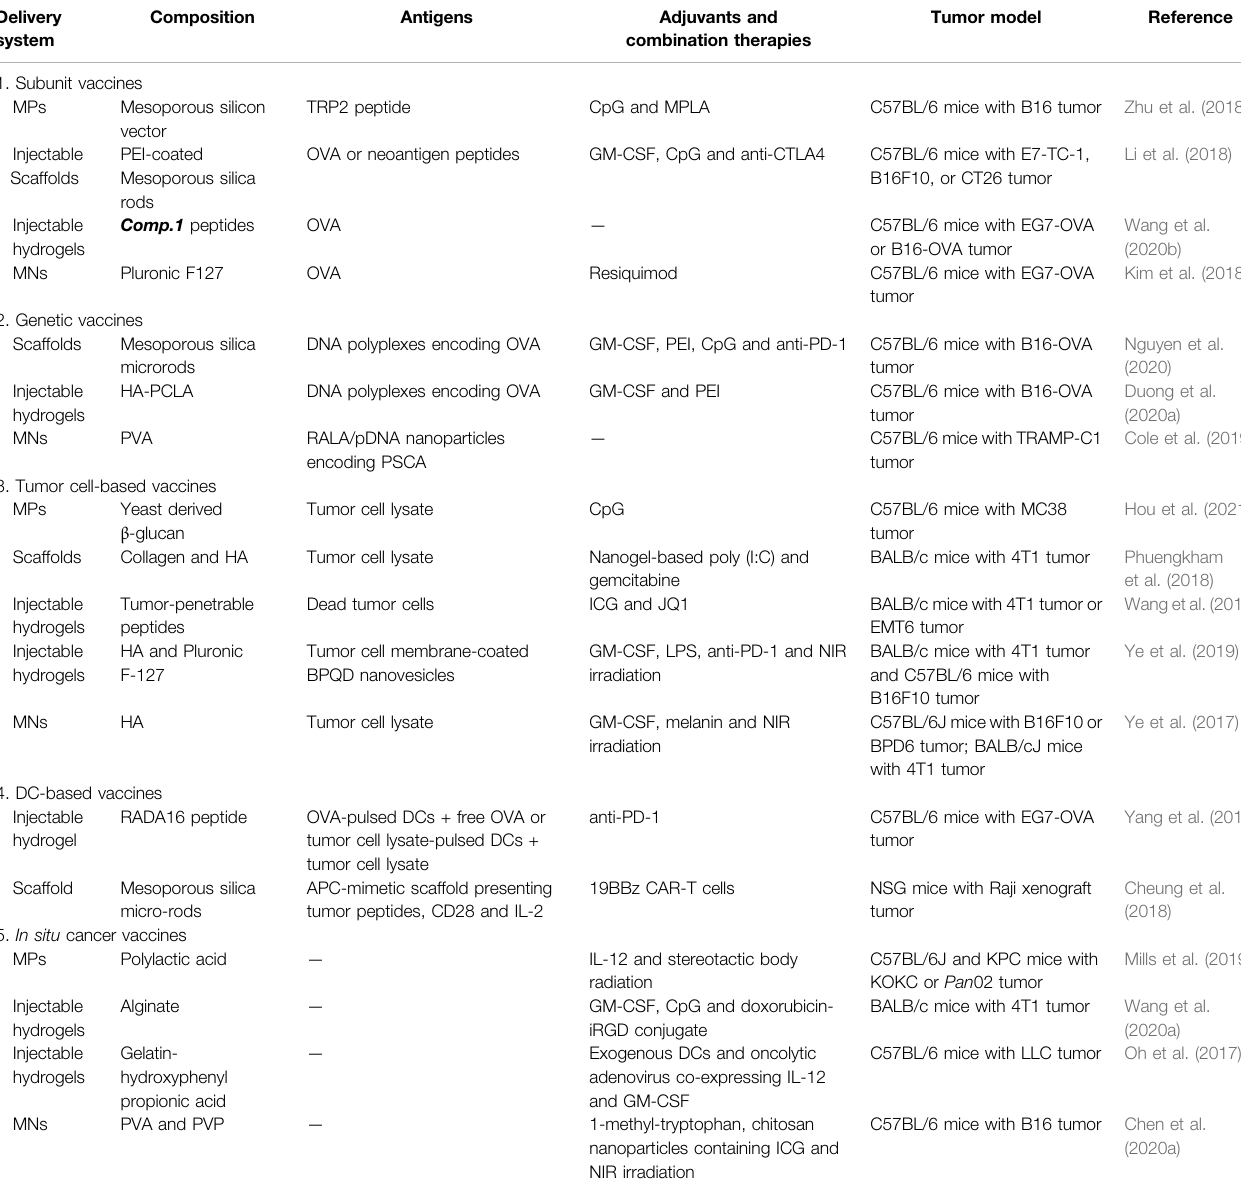
TABLE 2 | Representative examples of cancer vaccines delivered by controlled-release platforms (from 2017 to